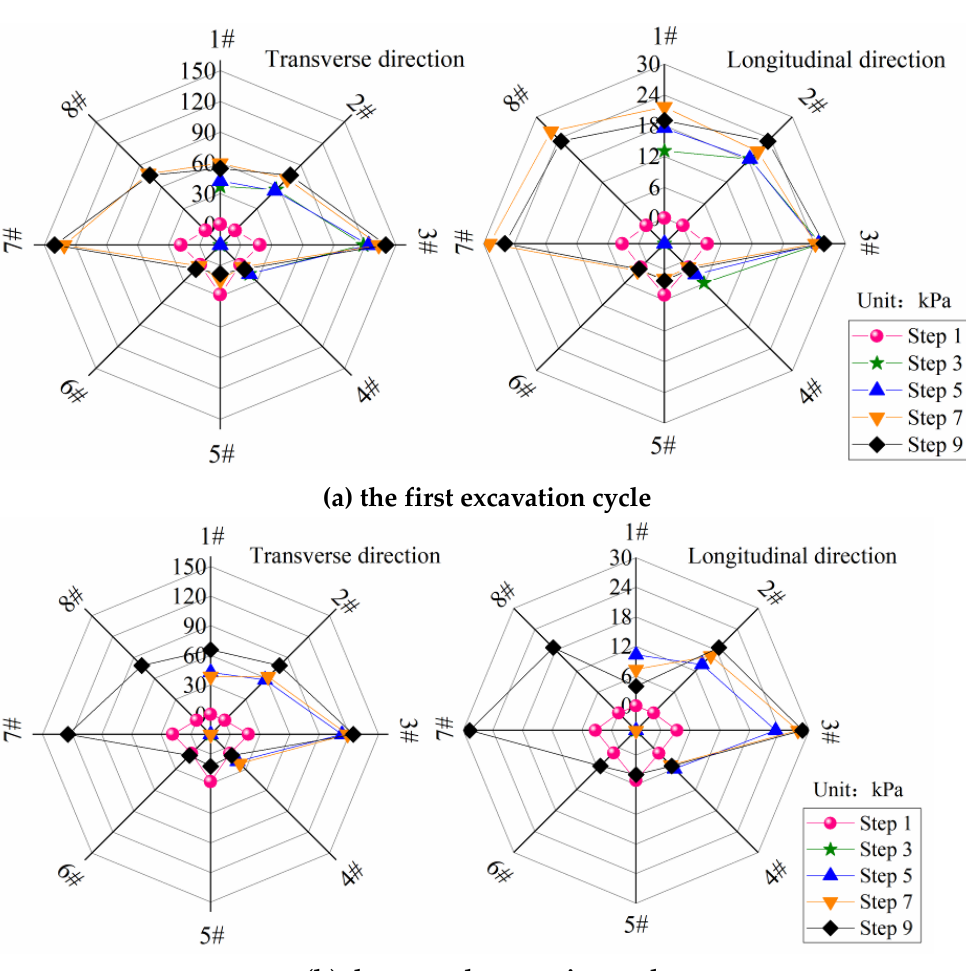
Figure 12. Measured stress in the excavation cycle (fault dip 75°).